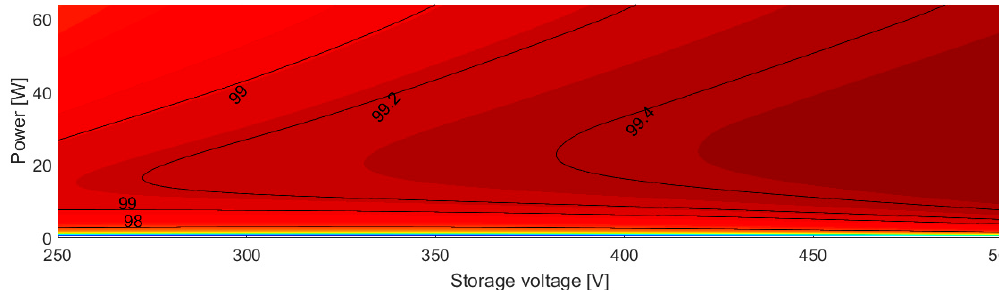
Figure 9. DC-DC SiC converter efficiency [%].